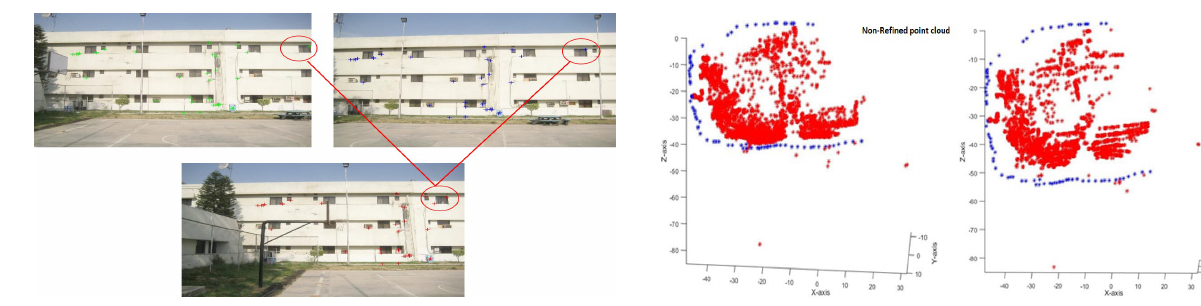
Figure 8. Triangulated point cloud